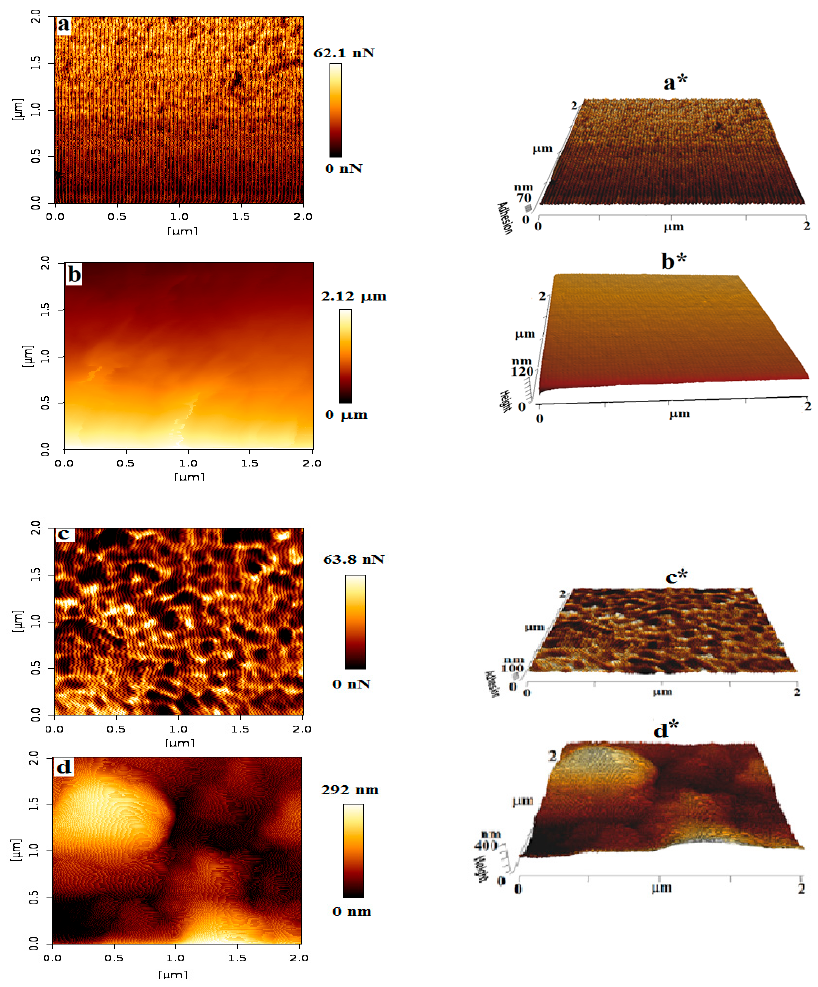
Figure 2. Atomic force microscopic (AFM) image of chitosan ( a , a* ) 2-D and 3-D image of adhesion and ( b , b* ) 2-D and 3-D image of height; and patch-5 ( c , c* ) 2-D and 3-D image of adhesion and ( d , d* ) 2-D and 3-D image of height. Table 1. Roughness and sheet resistance of chitosan-grafted PAni patch calculated from 2-D, image of height and four-probe technique, respectively.